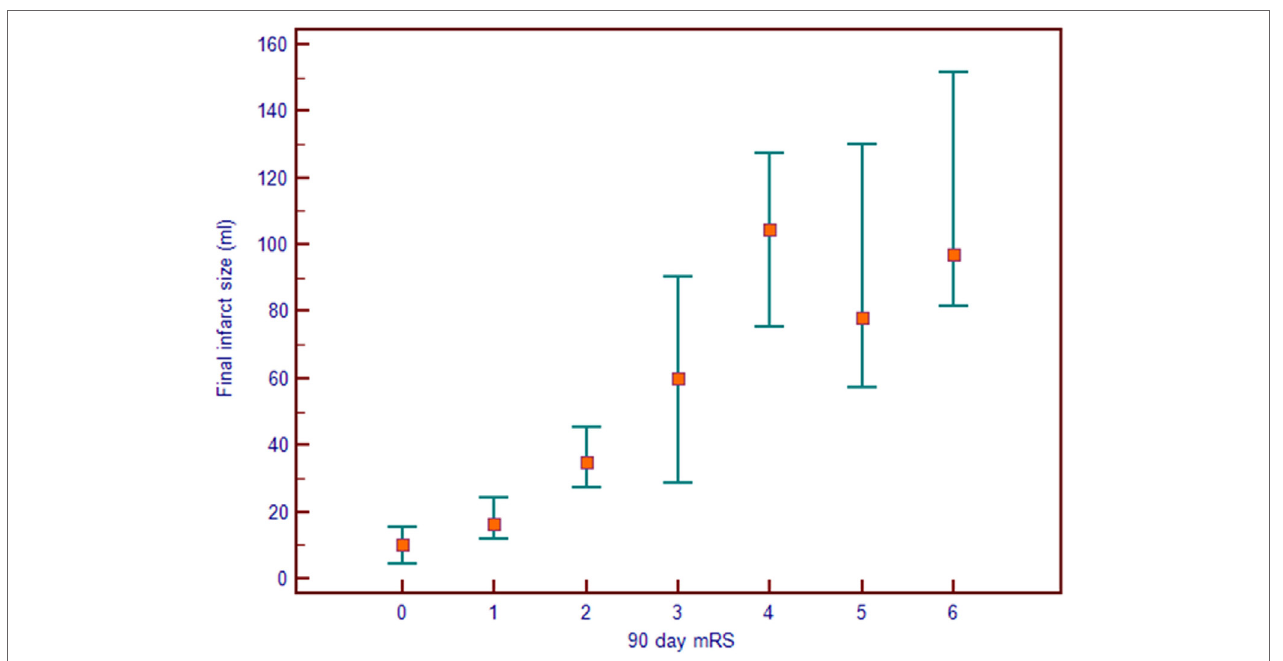
FigUre 1 | Final infarct size seen on the 24-h magnetic resonance imaging or computed tomography scan seen as a function of the 90-day modified Rankin Score (mRS). The median infarct is shown with a square and the markers denote 95% confidence intervals.